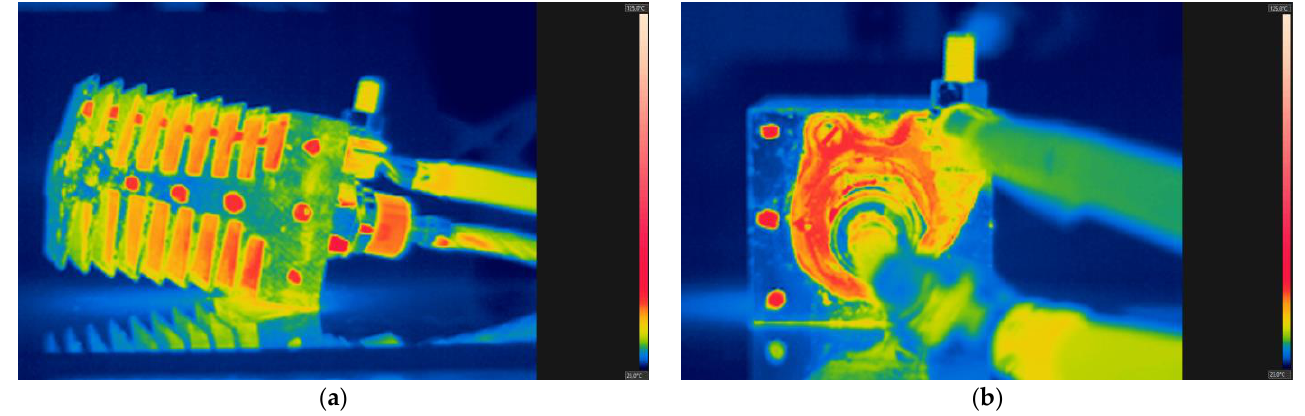
Figure 5. The thermograms showing a heat sink for a power of P j = 28.80 W: ( a ) side view; ( b ) top view. The temperature on the thermogram ranges from 23 °C to 125 °C.